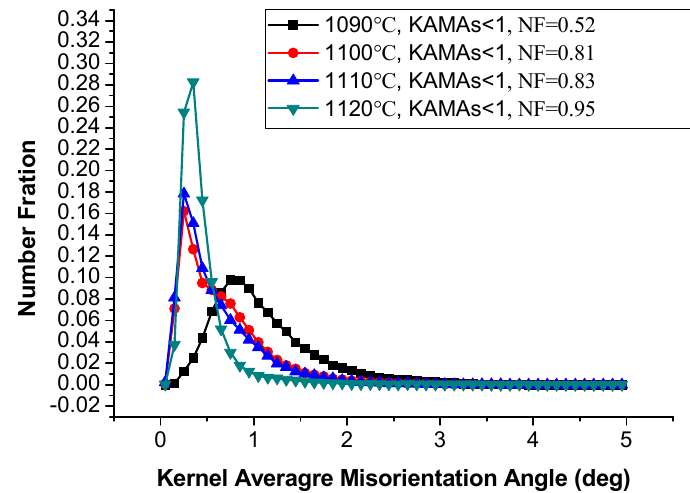
Figure 10. NF of KAMAs of 1090 °C/1100 °C/1110 °C/1120 °C.